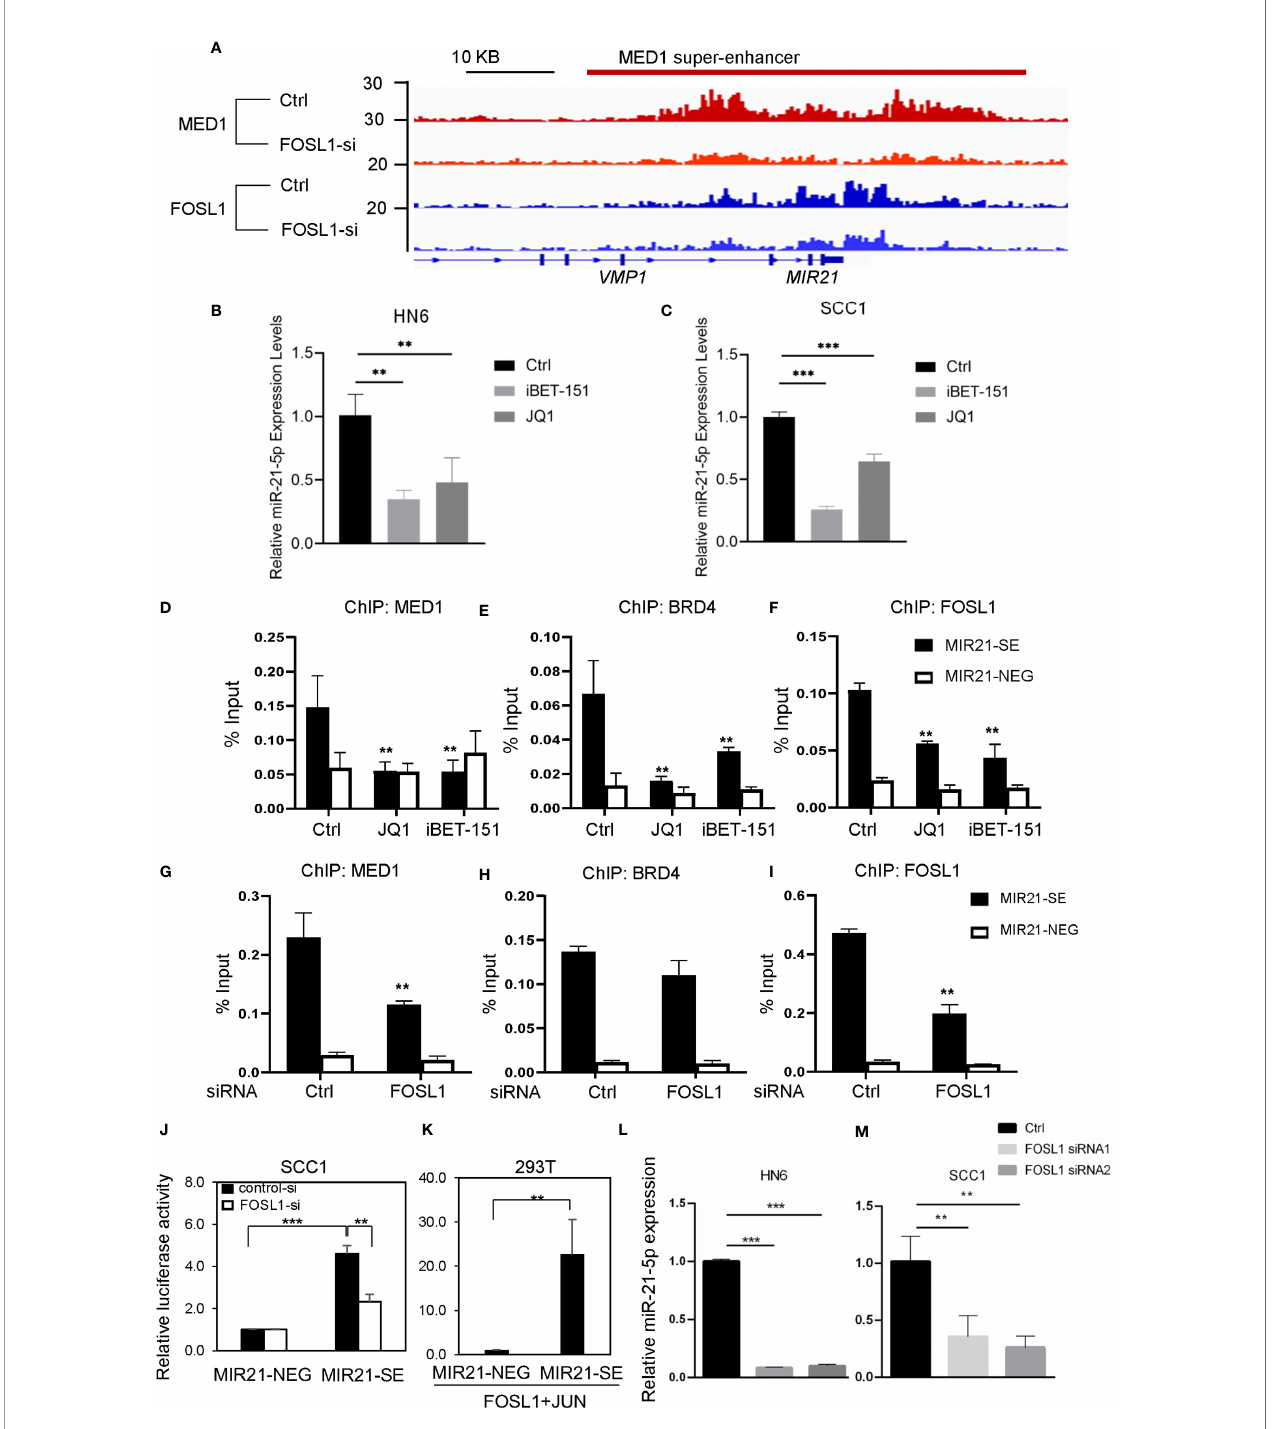
FIGURE 2 | Targeting FOSL1 suppresses miR-21-5p expression by interacting with the MIR21-SE. (A) ChIP-seq data revealed SE was formed around the MIR21 gene region and knockdown of FOSL1 suppressed the enrichment of MED1 and FOSL1 in the MIR21-SE. (B, C) Disruption of SE by JQ1 and iBET-151 inhibited the expression of miR-21-5p. **P< 0.01, ***P < 0.001 by one-way ANOVA. (D – F) The enrichments of MED1, BRD4 and FOSL1 in the MIR21-SE were eliminated in HNSCC cells upon JQ1 and iBET-151 treatment. **P < 0.01 by one-way ANOVA. (G – I) The enrichments of MED1 and FOSL1 in the MIR21-SE were eliminated in HNSCC cells treated with FOSL1 siRNA. **P < 0.01 by one-way ANOVA. (J) Knockdown of FOSL1 signi fi cantly suppressed the MIR21-SE luciferase activity. ***P < 0.001, **P<0.01 by one-way ANOVA. (K) MIR21-SE fragment was capable of elevating the luciferase reporter activity as compared to the negative control. **P < 0.01 by Student ’ s t-test (L, M) Knockdown of FOSL1 inhibited the expression of miR-21-5p. **P < 0.01, ***P < 0.001 by one-way